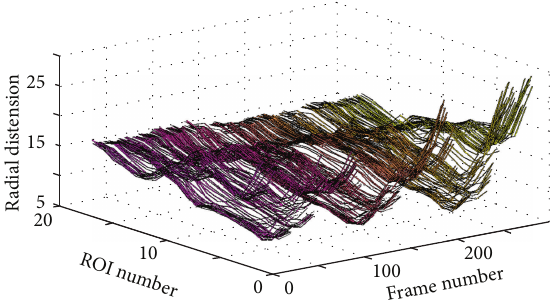
Figure 6: 3D plot showing the wave propagation along the vessel wall at different ROIs for the healthy young case Y1.